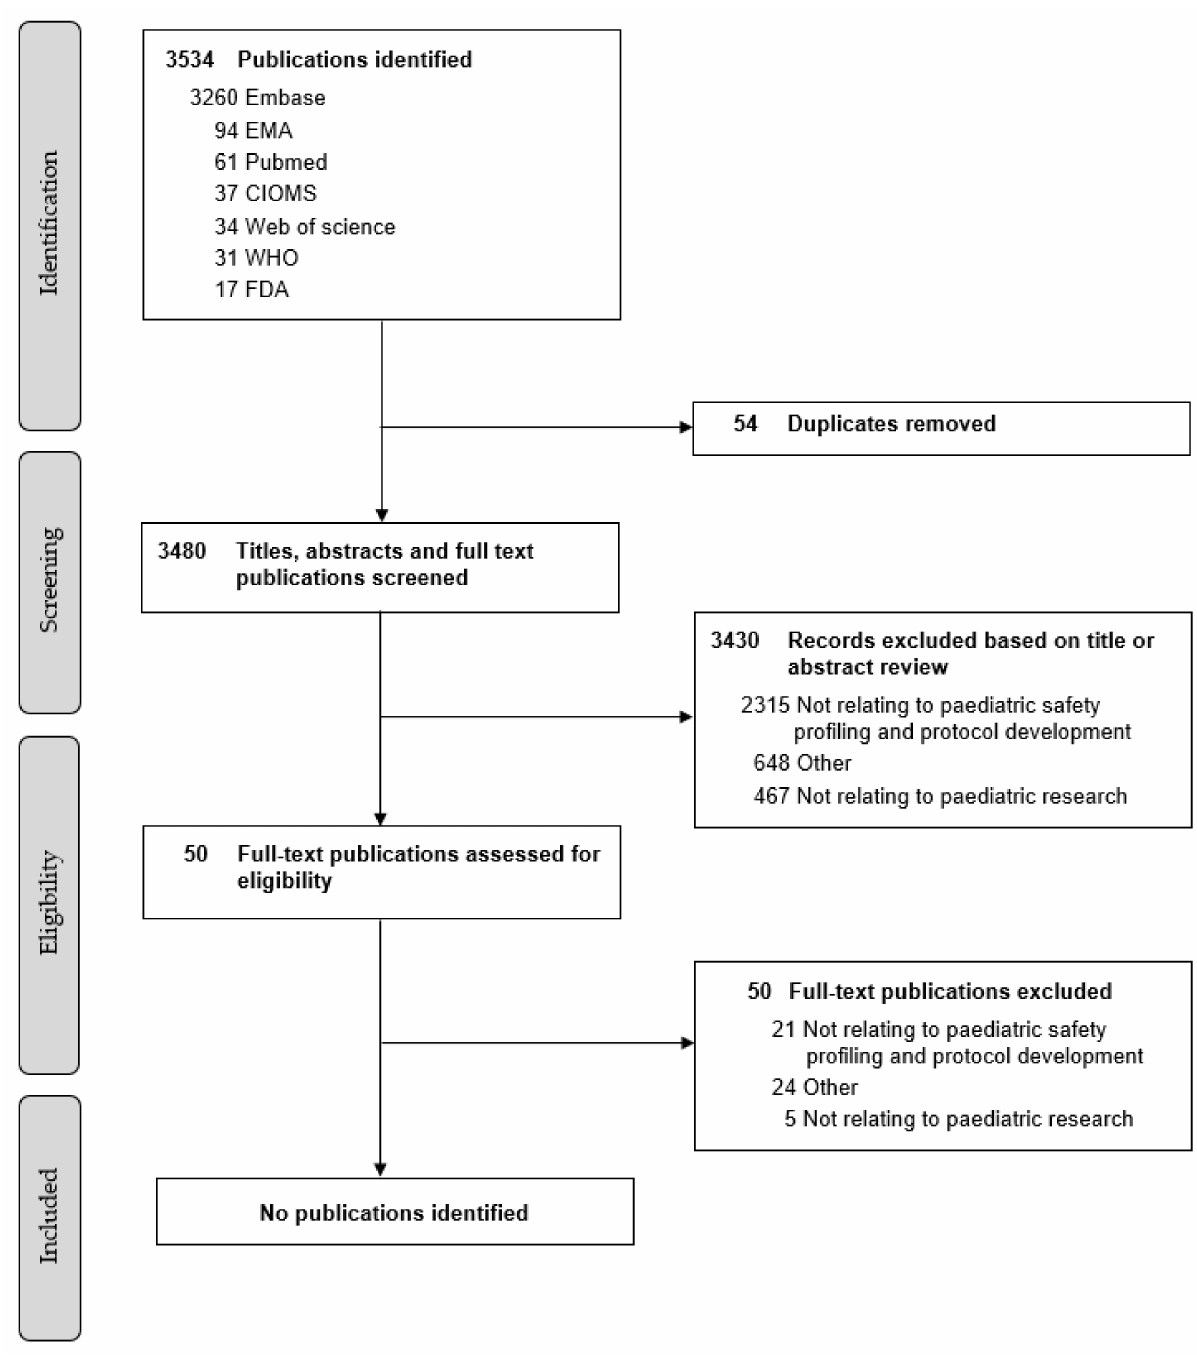
Figure A1. Paediatric safety profiling and protocol development: PRISMA Flowchart detailing selection of publications